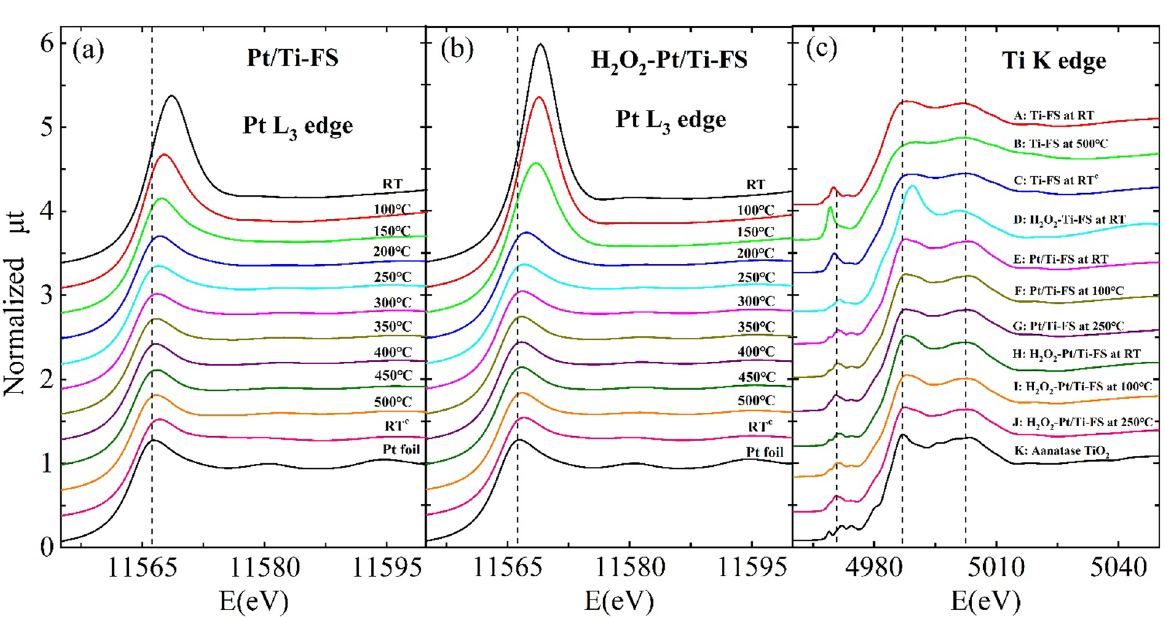
Figure 3. Normalized XANES (μt) spectra of ( a ) Pt/Ti–FS and ( b ) H 2 O 2 -Pt/Ti–FS at the Pt L 3 edge at different temperatures. ( c ) XANES spectra at the Ti K edge of A: Ti–FS at RT, B: Ti–FS at 500 °C, C: Ti–FS at RT c , D: H 2 O 2 –Ti–FS at RT, E: Pt/Ti–FS at RT, F: Pt/Ti–FS at 100 °C, G: Pt/Ti–FS at 250 °C, H: H 2 O 2 -Pt/Ti–FS at RT, I: H H 2 O 2 –Ti–FS and anatase TiO 2 , which were taken in air. The vertical dished lines are a guide to the